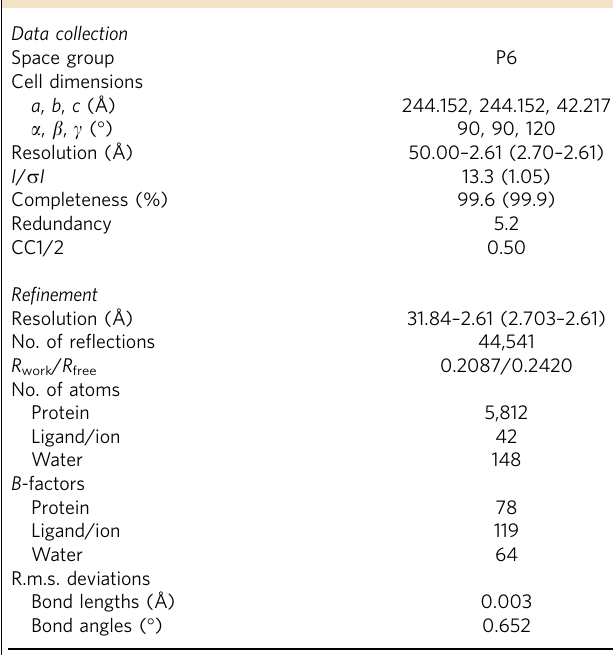
Table 1 | Data collection and refinement statistics (molecular replacement).